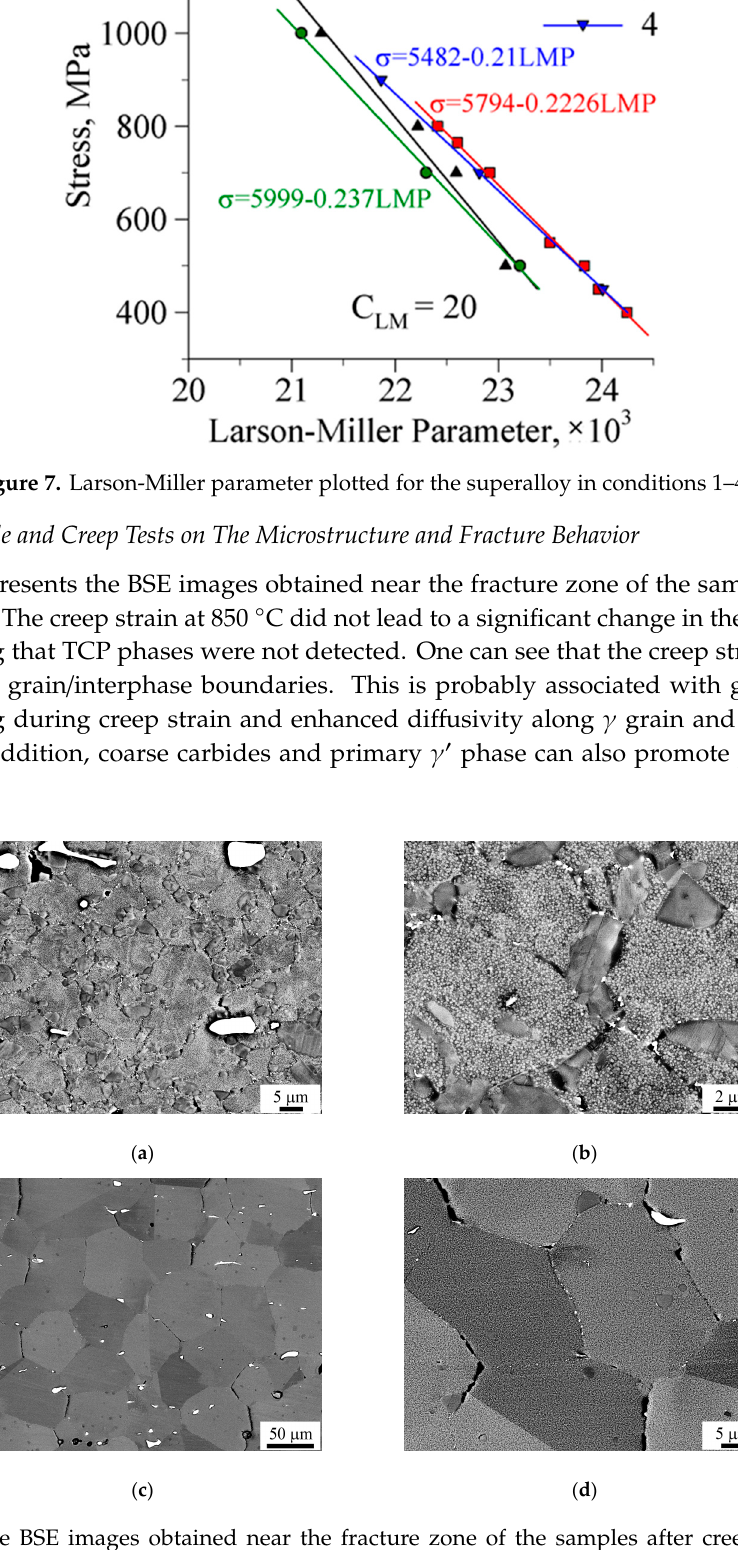
Figure 8. The BSE images obtained near the fracture zone of the samples after creep testing at 850 ° C/450 MPa: ( a , b ) condition 3, ( c , d ) condition 4. The loading direction is horizontal.